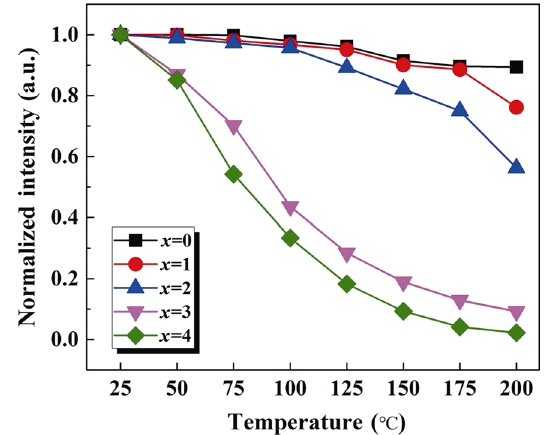
Fig. 10 Temperature-dependent luminescence intensity of Y 3 Al 5– x Ga x O 12 :Ce ( x = 0–4)